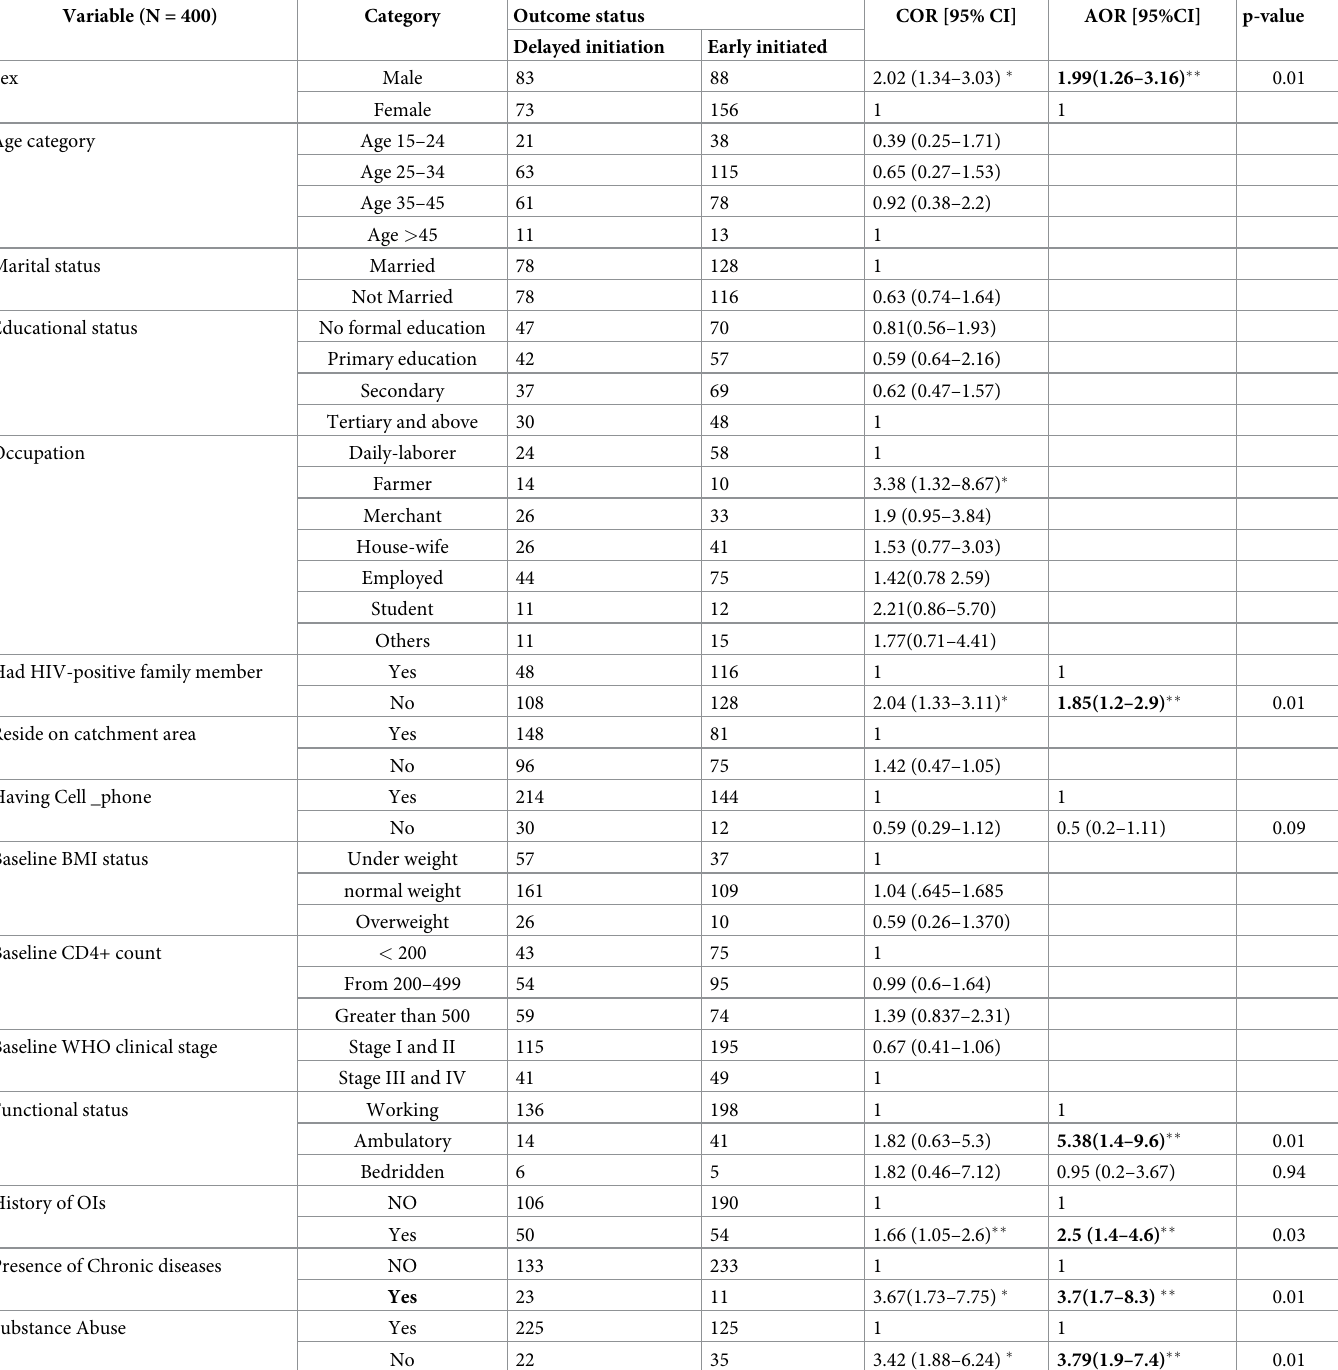
Table 3. Bivariable and multivariable logistic regression analysis result of delayed ART initiation among adult receiving ART at public health institutions in Bahir Dar city, Northwest Ethiopia,